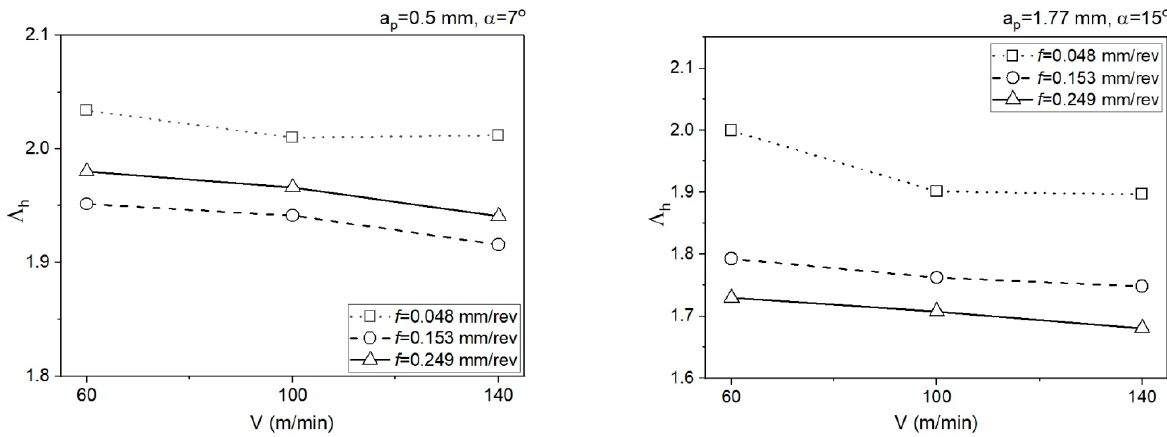
Figure 14. Impact of the cutting data on the values of the chip compression ratio for SSZ.